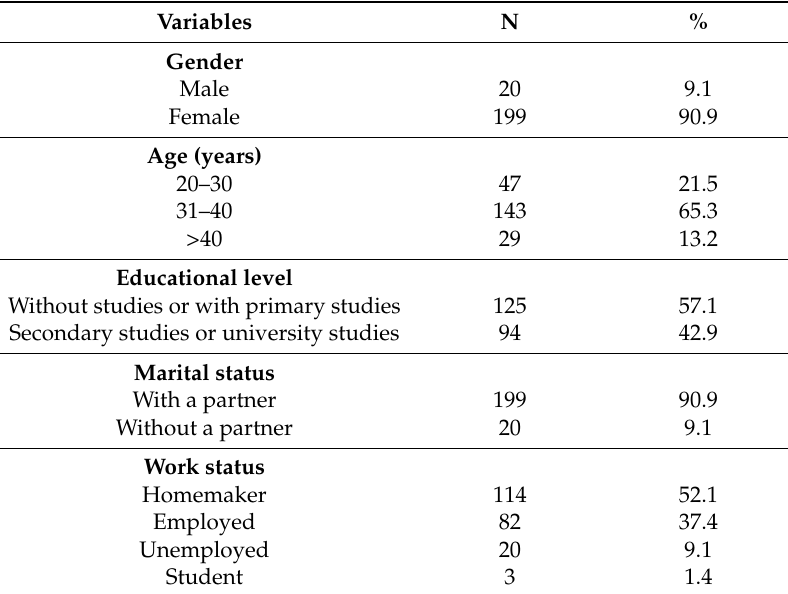
Table 1. Characteristics of the respondents ( n =